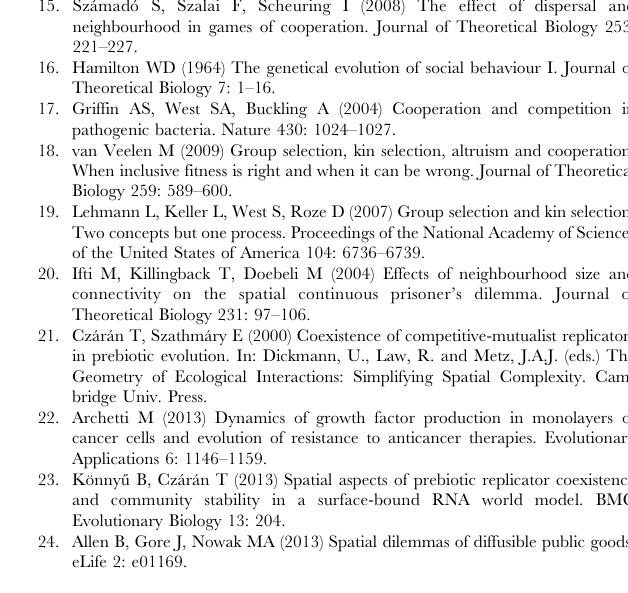
Figure S1 Graphical representation of stable and unstable meeting points of P and NP cells in function of n 1 and n 2 . Solid lines denote the stable while dashed lines denote the unstable states. a) The complete phase space. Arrows represent the motion qualitatively. Rectangles around the intersections are magnified in figure b) and c). b) The locally stable state. f Y (2) z , Z (2) z g , f X (1) z , X (1) z g , f X (2) z , W (2) z g and f Y (1) z , Y (1) z g are the intersections of m 1, z , n 2, z , n 1, z and m 2, z which determine s . c) The locally unstable state. Intersections of Γ N ~ 100 , l ~ 20 , a ~ 1 , n 1, { , m , n 2, { and m 1, { 2, { determine u . d ~ 0 : 5 . (EPS) Text S1 Mathematical Details. The proof that (26) and (27) can be valid simultaneously. (PDF)